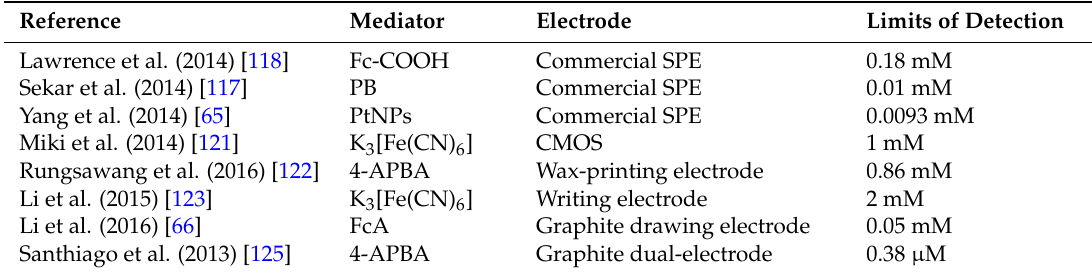
Table 2. Summary of the electrochemical µ PADs for glucose detection in representative references. FcA: Ferrocenecarboxylic